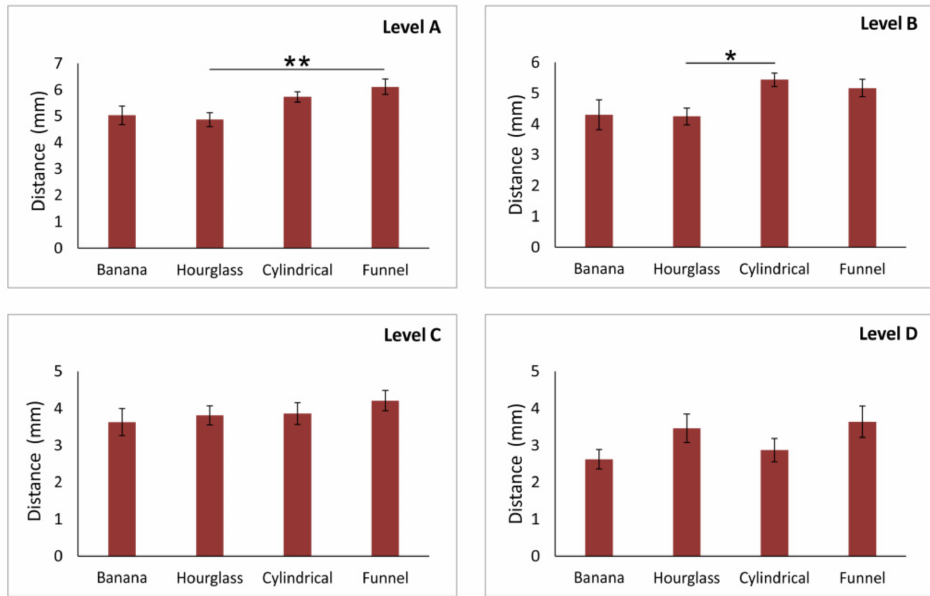
Figure 5. The distance of accessory canal from facial aspect of the buccal bone wall at different levels of anterior maxilla according to NPC shape. Values are expressed as the mean ± SEM. * denotes a significant difference of p < 0.05, ** denotes a significant difference of p <